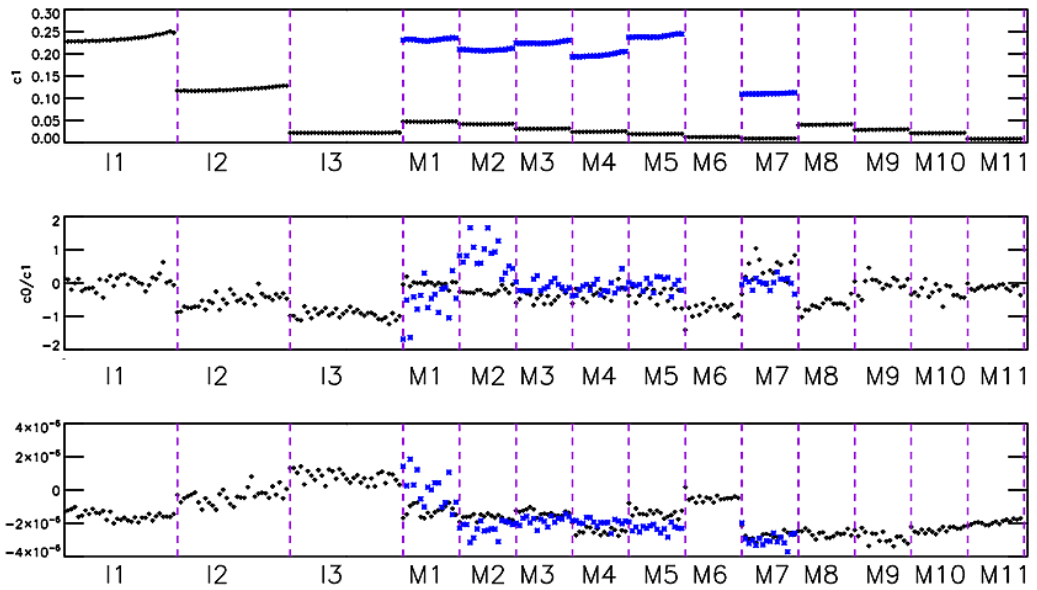
Figure 1. JPSS-3 VIIRS RSB coefficients for all detectors. Black and blue denote high and low gain,